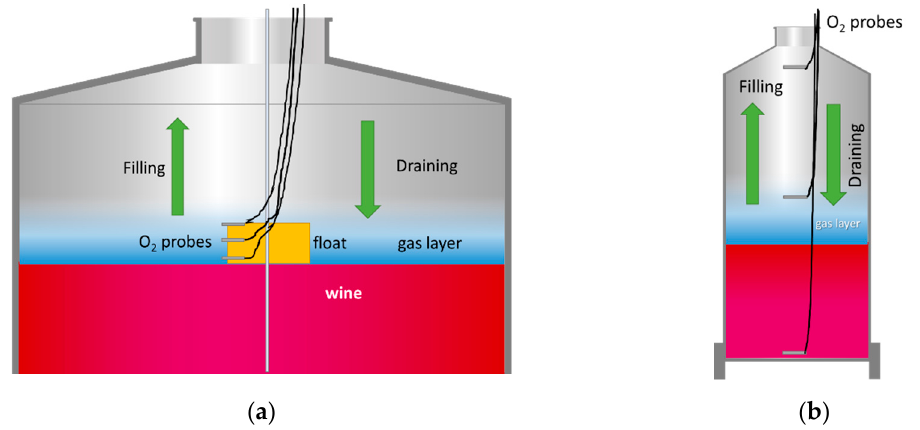
Figure 4. ( a ) Scheme of the float as well as the oxygen dipping probes at different constant distances from the liquid layer in gas mode; ( b ) Situation of the oxygen dipping probes located at three fixed heights in the liquid mode.